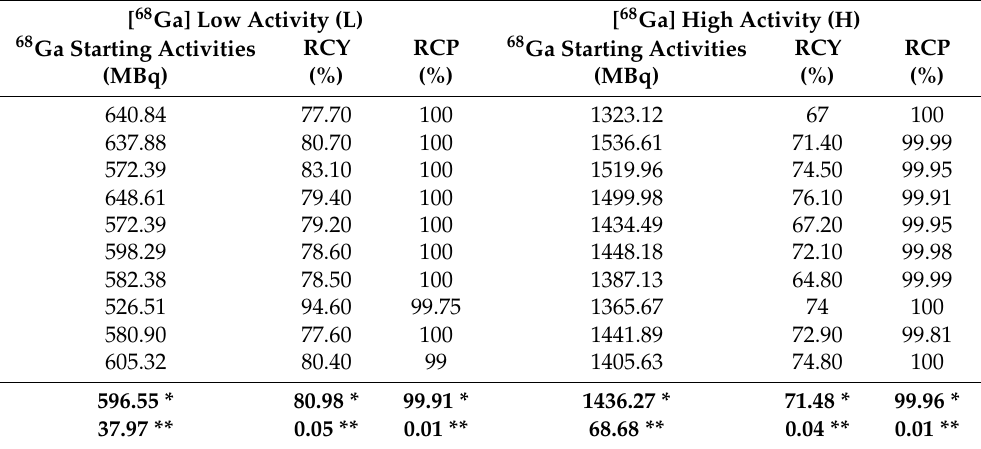
Table 1. Comparison of [ 68 Ga]Gallium chloride starting activities (low and high) and related RCY and RCP.